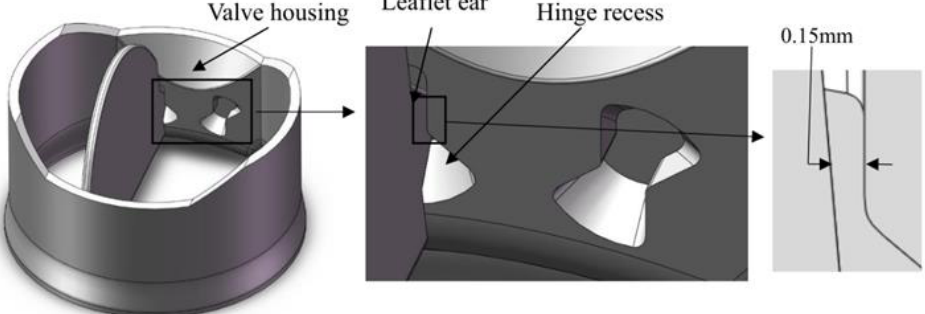
Figure 1. Hinge recess and leaflet ear of the modeled On-X valve.